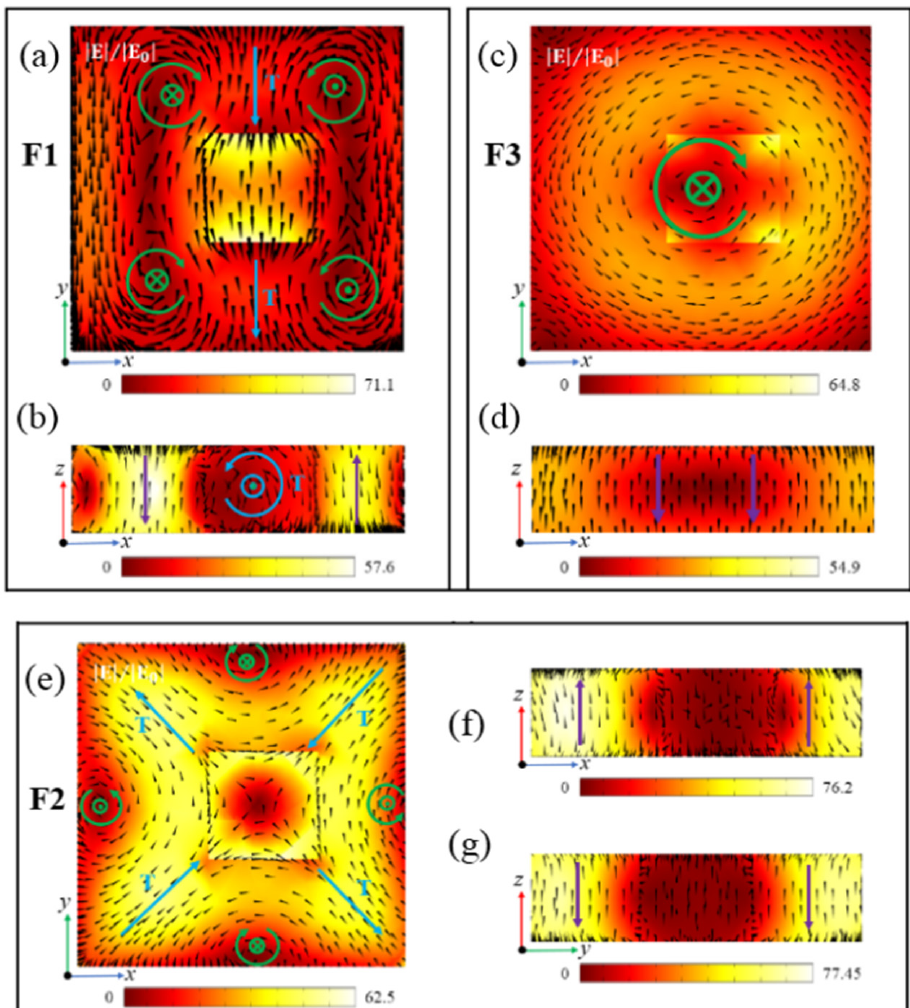
Figure 7. When g = 40 nm, the symmetry of the SHND nanostructure is broken. ( a , c , e ) show the electric field enhancement and electric field vector distribution of F1, F2, and F3 in the x – y plane. ( b , d , f ) show the magnetic field enhancement and magnetic field vector distribution of F1, F2, and F3 in the x – z plane. ( g ) shows the magnetic field enhancement and magnetic field vector distribution of F2 in the y – z